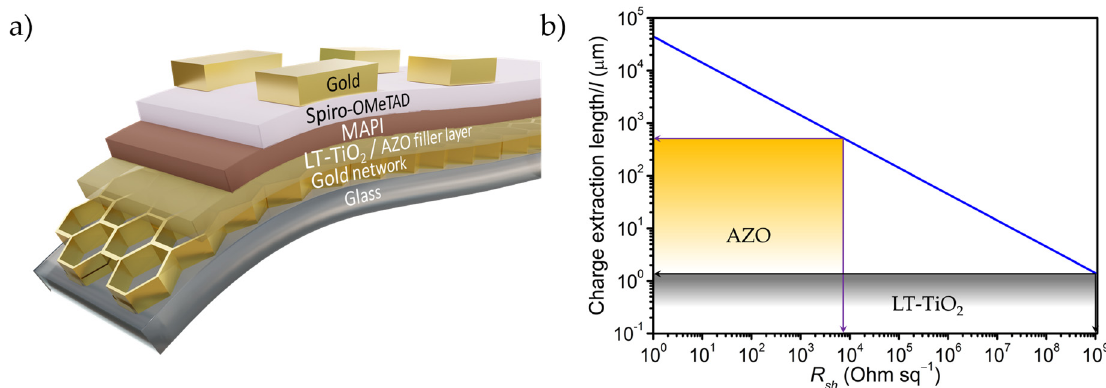
Figure 3. ( a ) Schematic representation of the planar perovskite solar cell device configuration and corresponding stacks used in this work; ( b ) Effective charge extraction length of LT-TiO 2 and AZO filler layers corresponding to their R sh values deduced for 10 mV voltage loss from Figure 1.